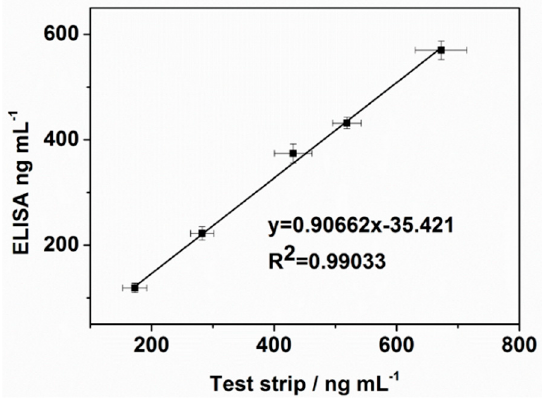
Figure 6. Results Comparison between the MCNT-based LFI and Commercial Immunoassay ELISA Kit.